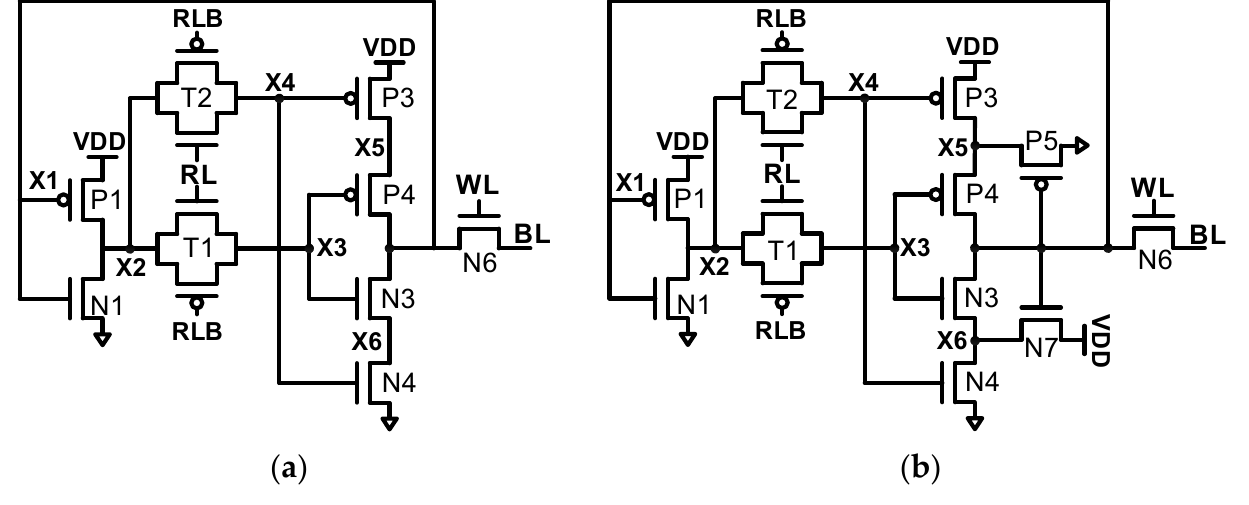
Figure 9. Schematic of ( a ) RHD-11 T and ( b ) RHD-13 T SRAM cell. RHBD-11 T, RHBD-13 T, RHD-11 T, and RHD-13 T all have full immunity to single node upsets and even have enhanced robustness to multiple node upsets. However,